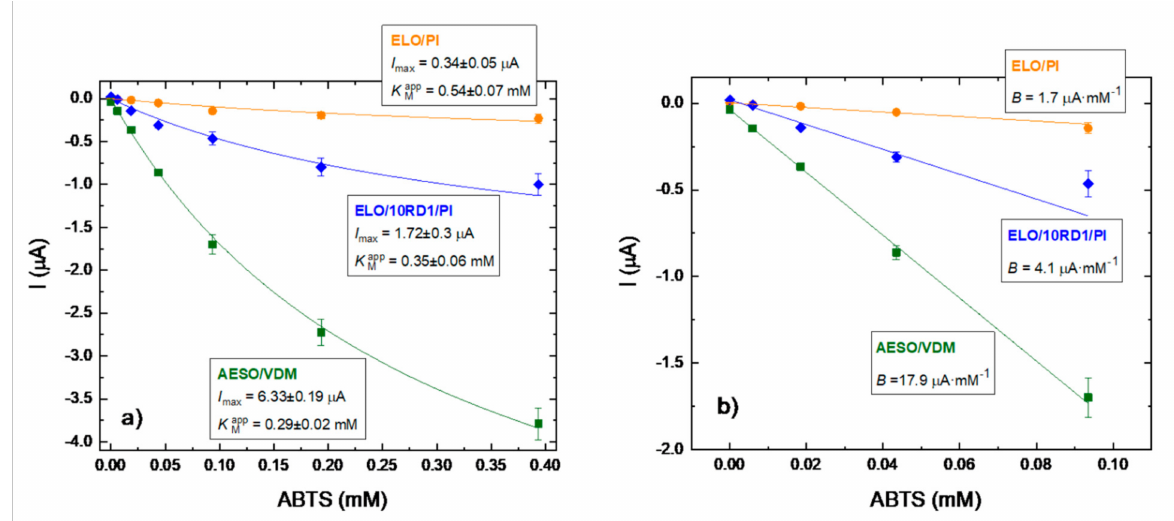
Figure 12. Calibration curves of chronoamperometric response ( a ) and analysis of linearity range and sensitivity ( b ) on the increasing concentrations of ABTS for the laccase bioelectrodes formed with different polymer matrixes. Conditions: working potential − 100 mV vs. Ag/AgCl (3 M KCl), 50 mM acetate buffer, pH 4.5 at 23 ◦ C and constant stirring.